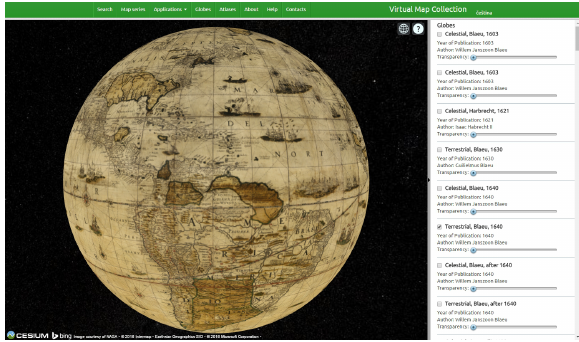
Figure 6. Digital model of the globe (JavaScript library Cesium)